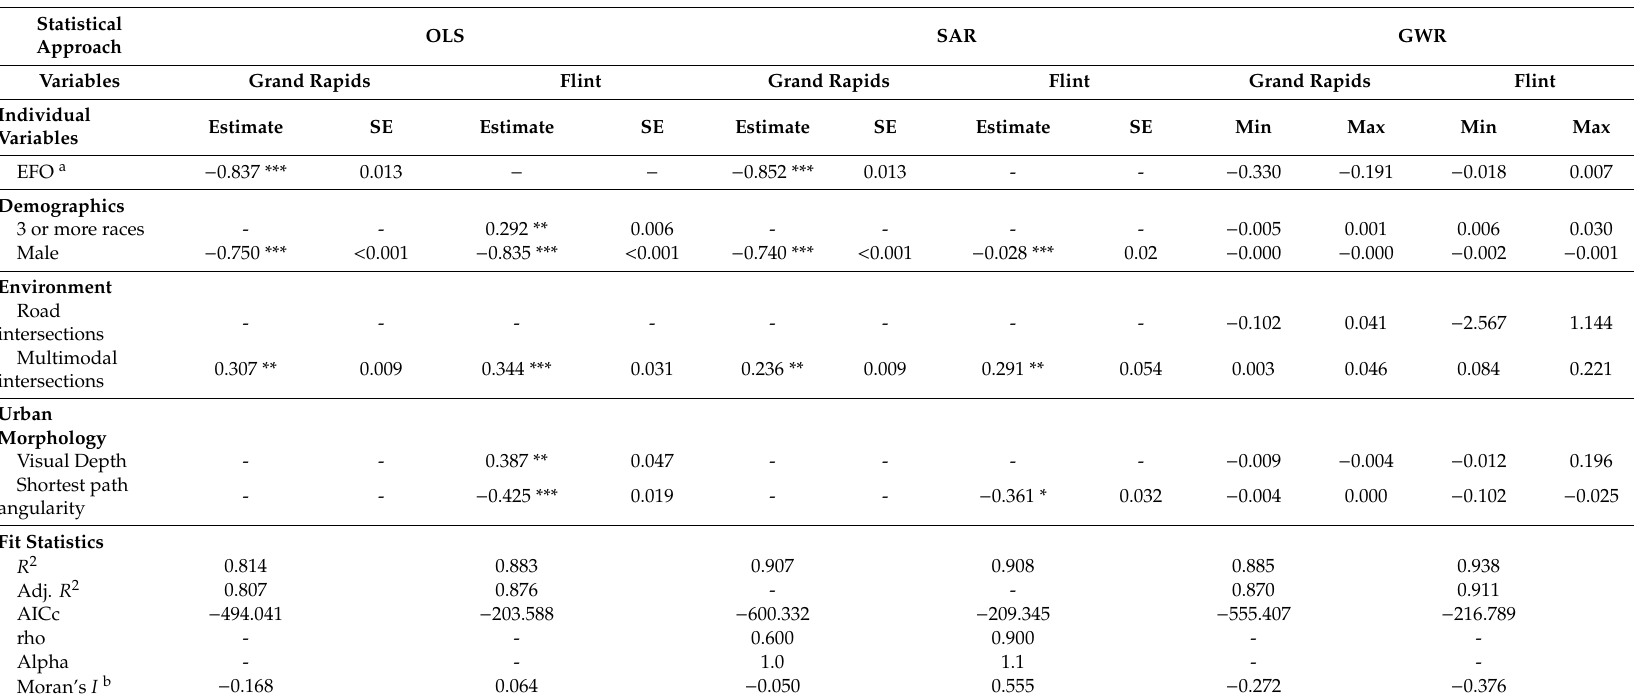
Table 6. Flint ( n = 56) and Grand Rapids ( n = 159) mass-transit zone fully adjusted model coe ffi cients and diagnostic outputs. Statistical